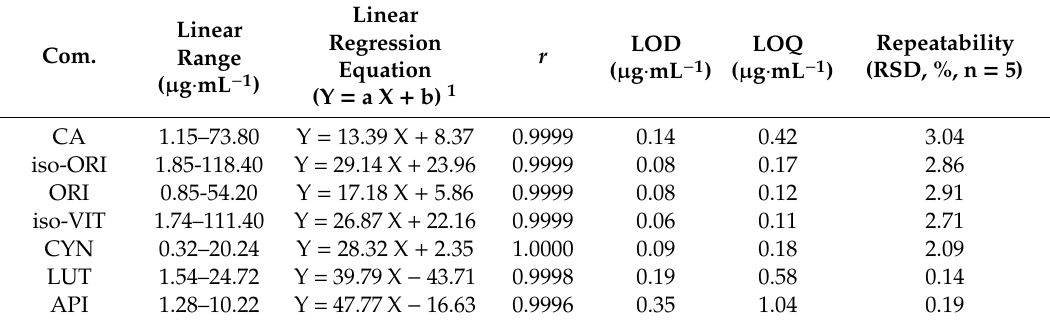
Table 1. The results of linearity, LOD, LOQ, and repeatability. RSD, relative standard deviation. CA, chlorogenic acid; iso-ORI, isoorientin; VIT, vitexin; CYN, Cynaroside; LUT, Luteolin; API, Apigenin.